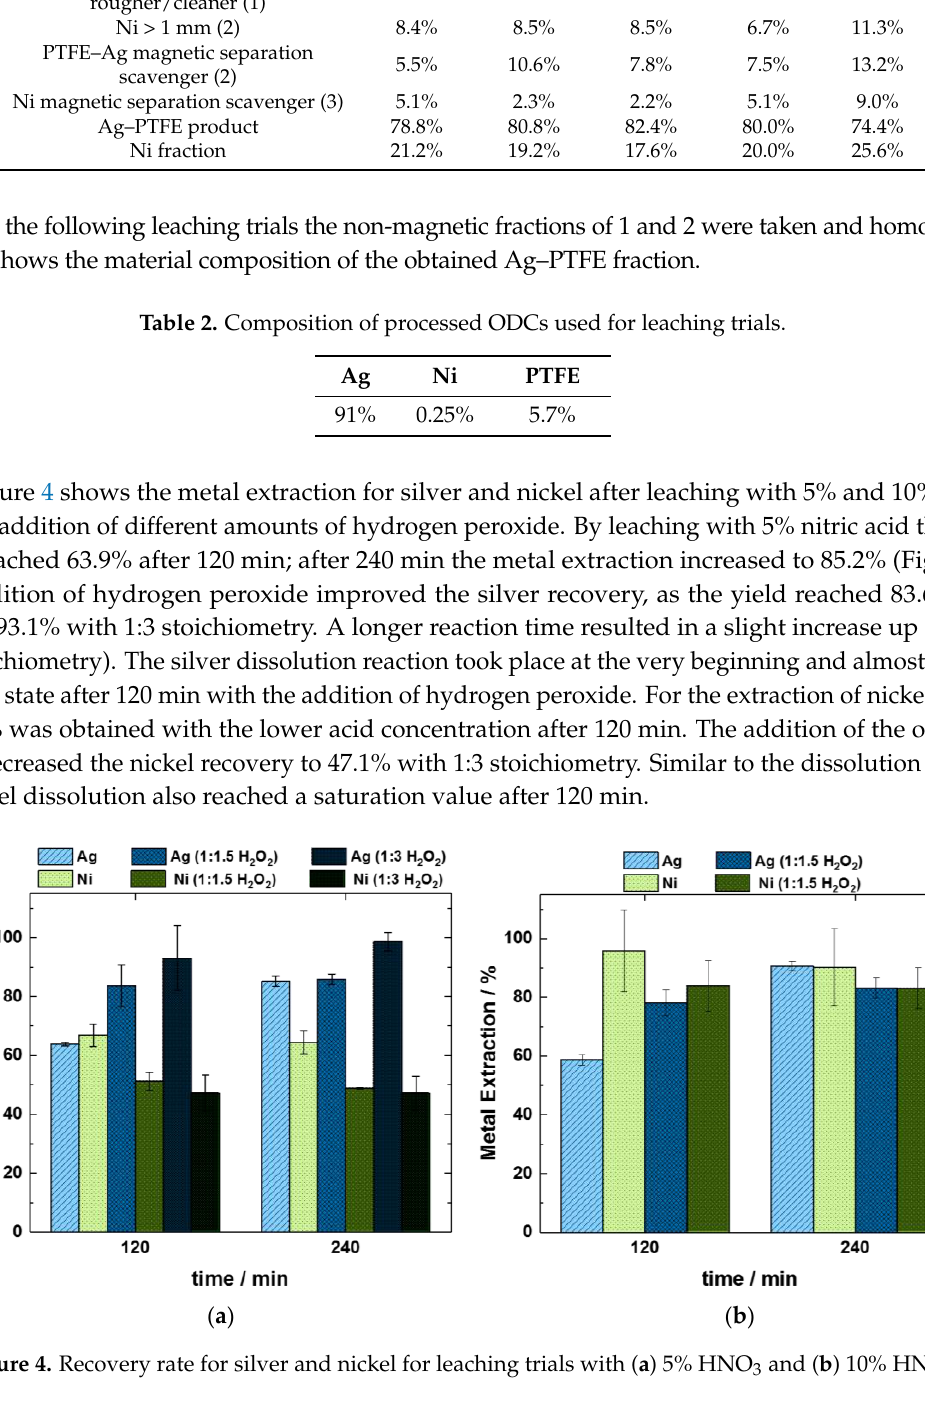
Table 1. Mass recoveries of mechanical processing tests.